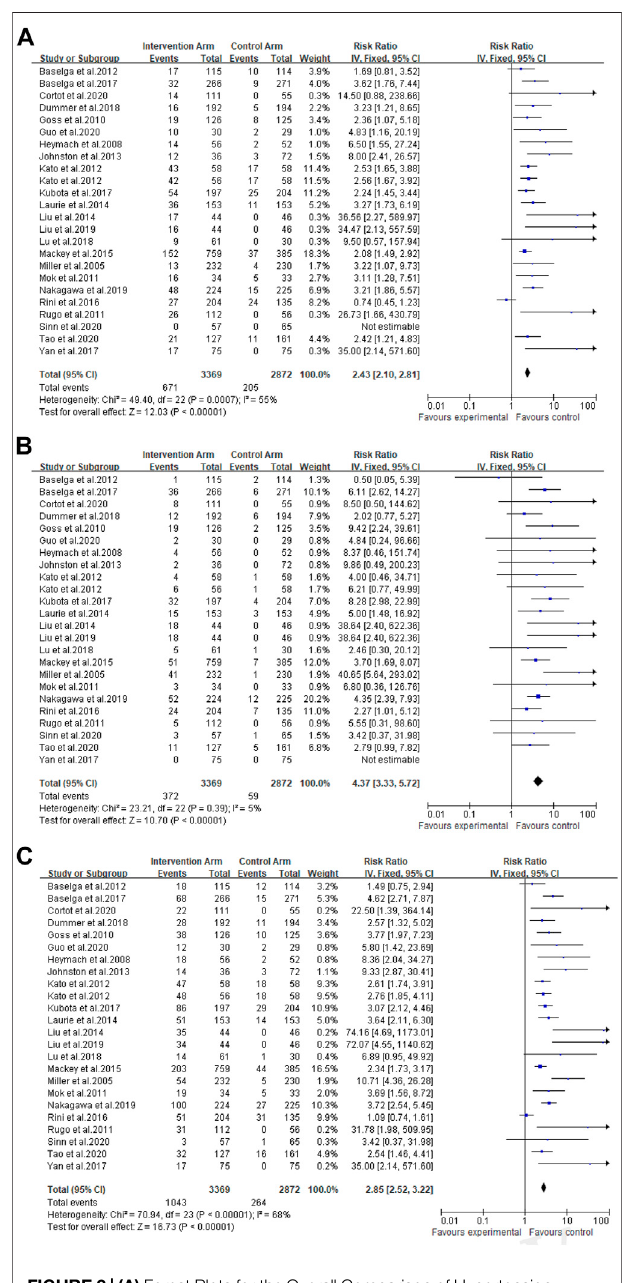
FIGURE 2 | (A) Forest Plots for the Overall Comparison of Hypertension caused by cancer combination therapy. (B) Summary Relative Risks for Hypertension at Grade 3 – 4. (C) Summary Relative Risks for Hypertension at All Grade.